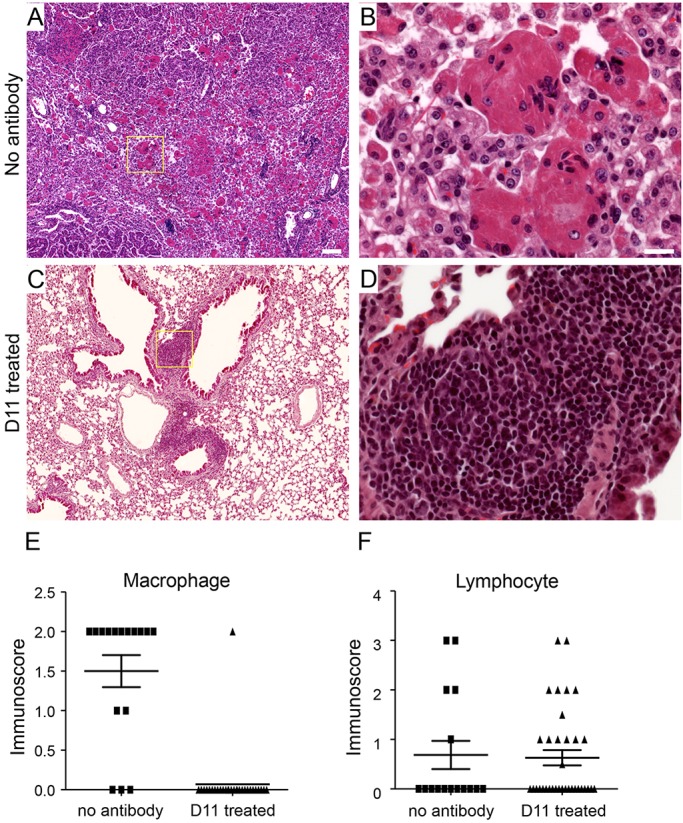
Decreased infiltration of multinucleated macrophages in mice treated with D11 antibody. (A,B) Lung histology from Sftpc-rtTA, Tre-Fgf9-Ires-eGfp mice induced with doxycycline for 16 days, but not treated with D11 antibody, showing a tumor nodule with dense infiltration of large cells referred to as multinucleated macrophages. (C,D) Lung histology from Sftpc-rtTA, Tre-Fgf9-Ires-eGfp mice induced with doxycycline for 16 days and treated with D11 antibody showing lack of multinucleated macrophage infiltration but occasional presence of lymphocytic nodules. Boxes in A,C are magnified in B,D. (E) Semi-quantitative immunoscore for multinucleated macrophages showing significantly reduced (P<0.0001) infiltration in D11-treated mice (n=29) compared with control (n=16). (F) Immunoscore for lymphocytes shows no significant difference between D11 antibody-treated (n=32) and untreated (n=16) mice. Scale bars: A, 100 µm; B, 20 µm.